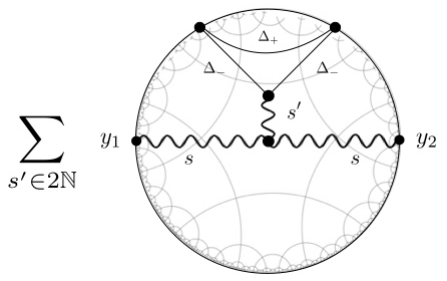
Figure 14. Re-summation of tadpole diagrams with a single-cut of the scalar loop. The in(cid:12)nite sum over spin s 0 and the divergent integration over the boundary seem not to